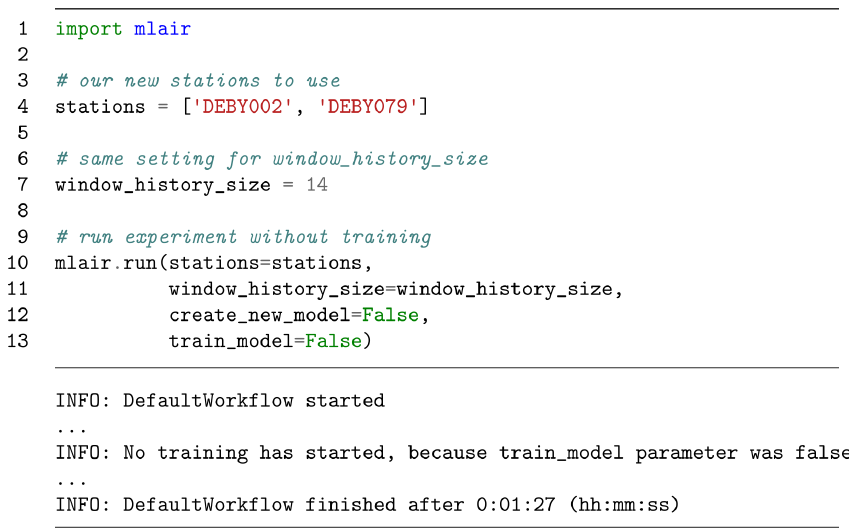
Figure 4. Experiment run without training. For this, it is required to have an already trained model in the experiment path.